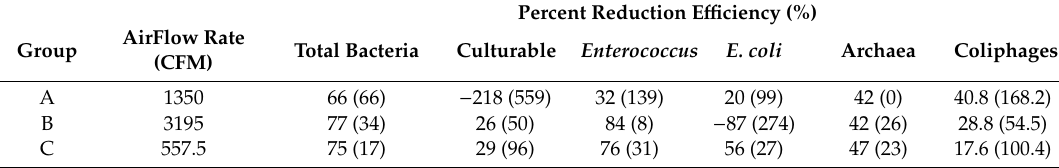
Figure 1. Percent reduction e ffi ciencies of ATU against all detectable studied microorganisms. The graphs represent ATU reduction e ffi ciencies for archaea, F + RNA coliphages (group I), bacteria cultured on tryptic soy agar (TSA), Escherichia coli , Enterococcus , and total bacteria by qPCR. Red arrows refer to reduction e ffi ciencies calculated using the limit of quantification for downwind or upwind data. Table 3. Percent reduction e ffi ciencies for analyses by grouping. Median values reported with interquartile range (IQR) in brackets. Negative values indicate an increase in treated air concentration. Flow rate (CFM = cubic feet per minute) is the median of values recorded during the time of sampling for each